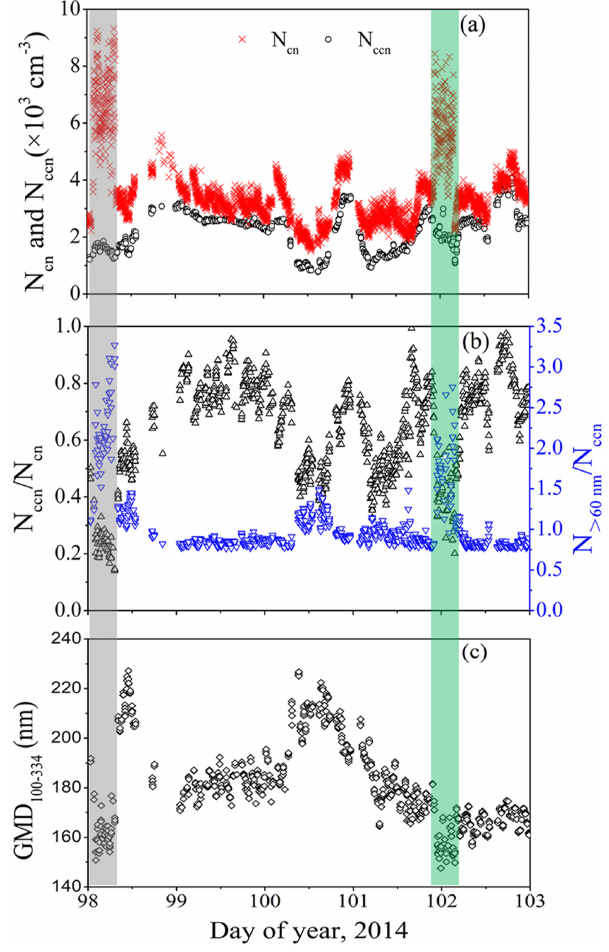
Figure 7. Time series of the N cn , the bulk N ccn , N ccn /N cn , N > 60nm /N ccn and GMD 100 − 334 at SS of 0.4% during DOY 98– 102, 2014. The gray shading indicates the dust event and the green shading indicates the BB